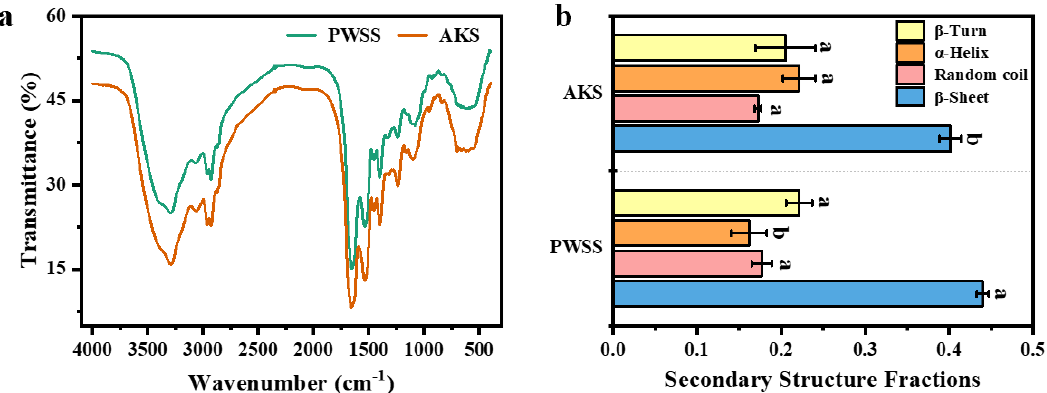
Figure 6. FTIR of Antarctic krill and Pacific white shrimp surimi gels: ( a ) FTIR spectra curve, and ( b ) the change of secondary structure. PWSS, Pacific white shrimp surimi; and AKS, Antarctic krill surimi. Different letters (a–d) within the same protein structure tested indicate significant differences ( p < 0.05).